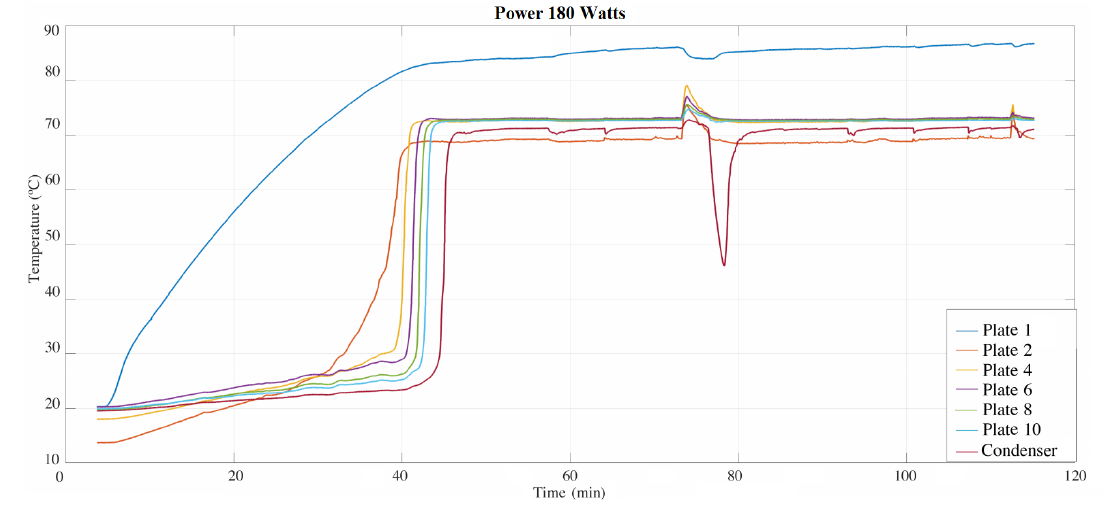
Figure 19. Thermal behavior of the distillation column using a non-regulated power